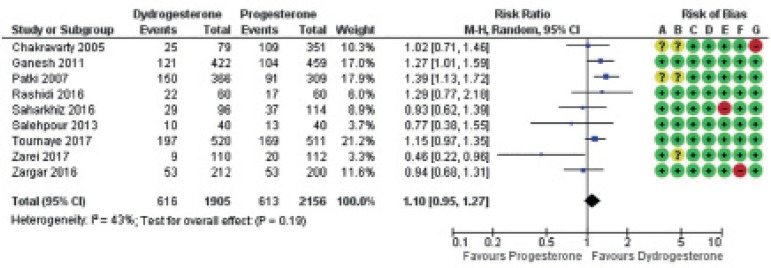
Forest plot for clinical pregnancy. Risk of bias legend: A = f4
Selection bias (random sequence generation); B = Selection bias
(allocation concealment); C = Performance bias; D = Detection bias;
E = Attrition bias; F = Reporting bias; G = Other biases.